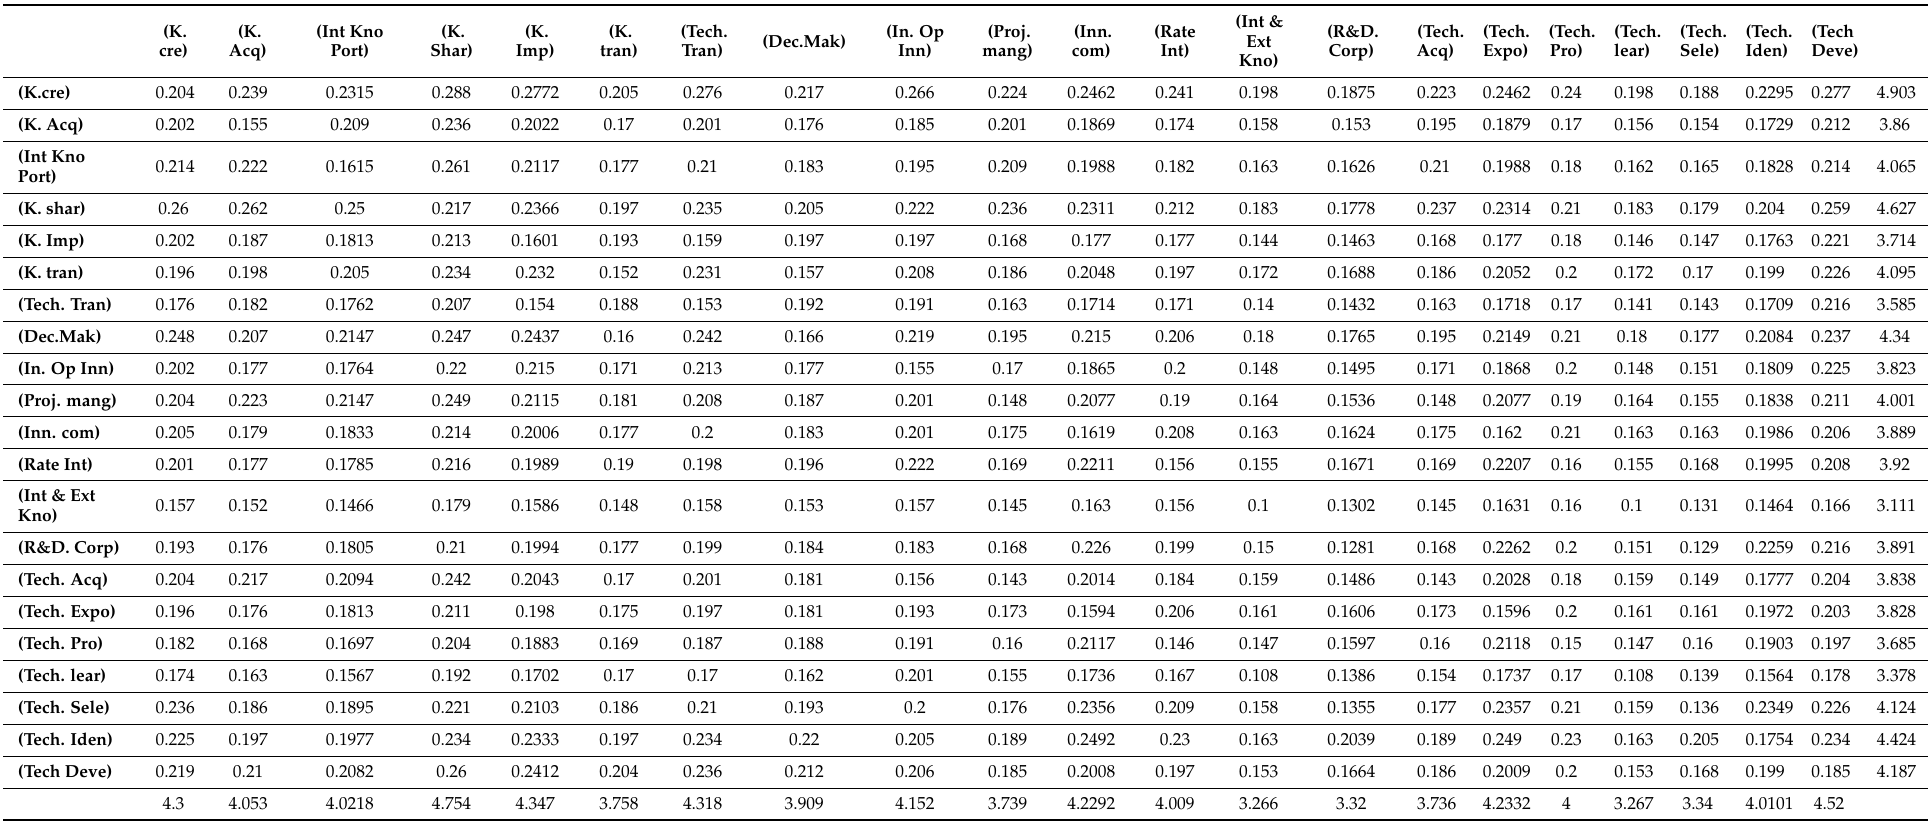
Table 6. Total relation matrix T (Criteria)